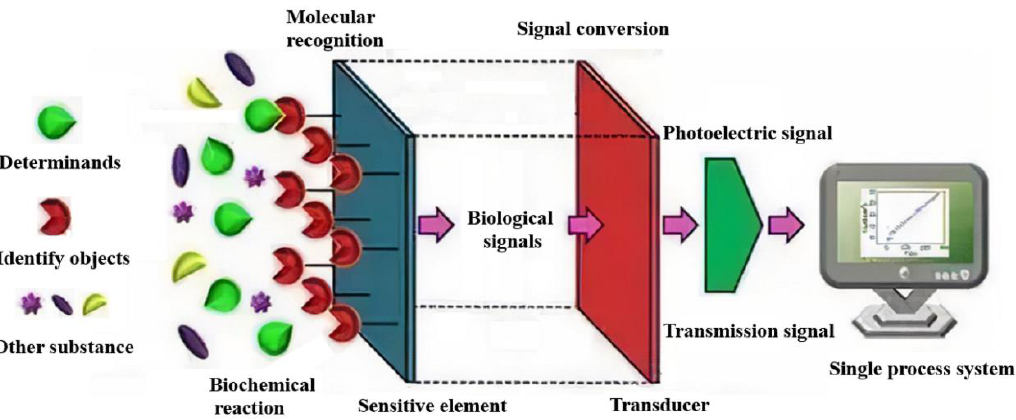
Figure 1. Schematic composition of biosensors.